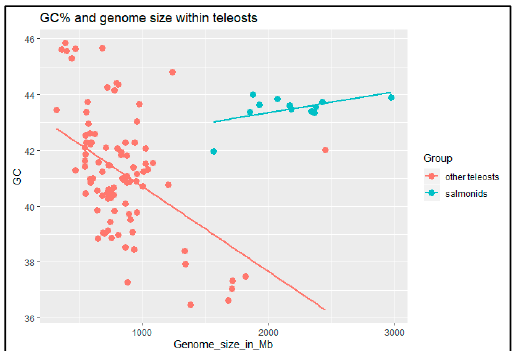
Figure 4. Scatter plot showing the relationship between GC% and genome size in salmonids and other teleosts. Data from https://www.ncbi.nlm.nih.gov/genome/browse#!/overview/.